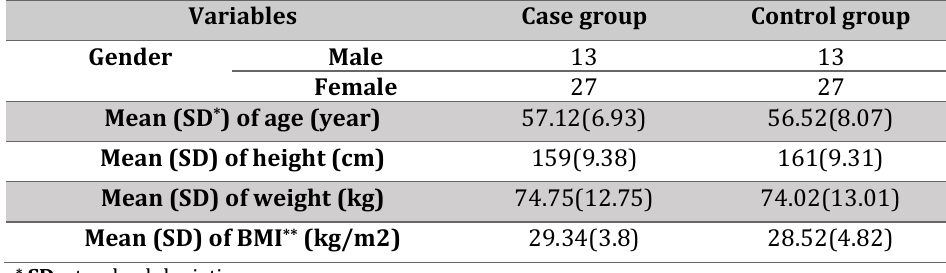
Table 1 . Participant’s demographic data according to their groups.